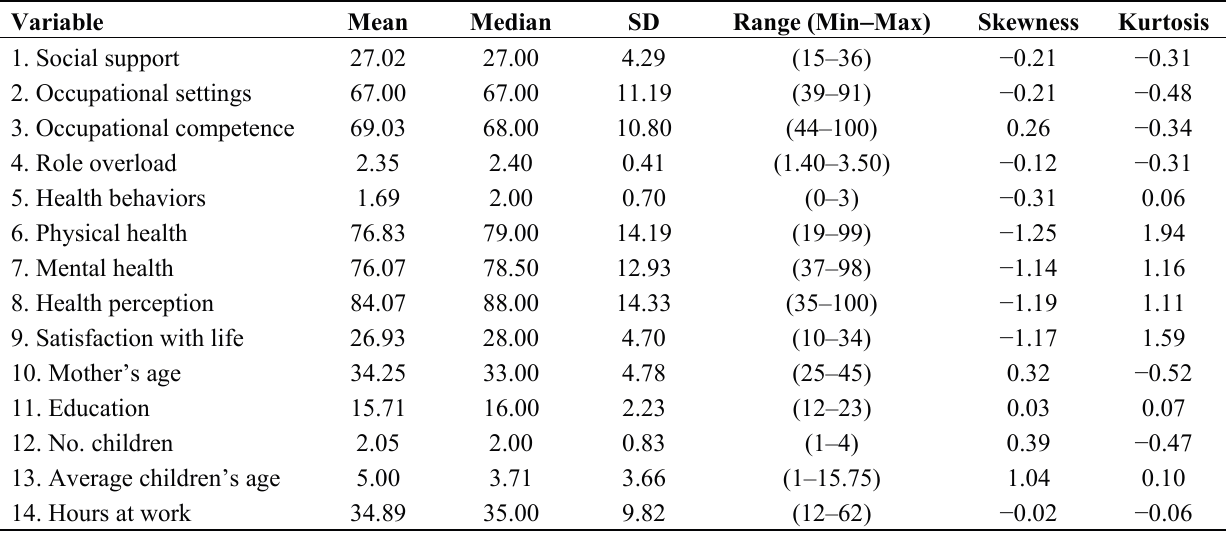
Table 2. Descriptive statistics of study variables (N = 150).